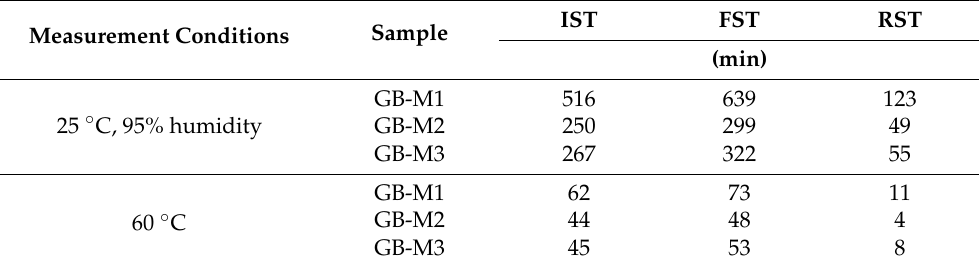
Table 3. The initial, final and real setting time of geopolymer binders produced with different aluminosilicates at 25 ◦ C and 60 ◦